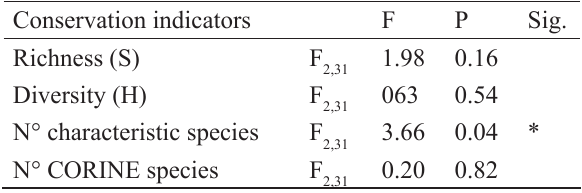
Table 3. ANOVA results for the conservation indicators